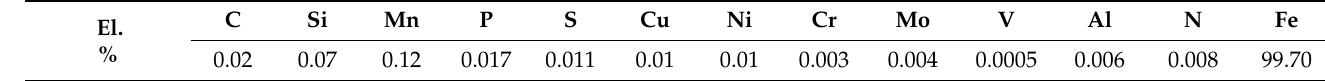
Table 1. The chemical composition of the high-purity iron